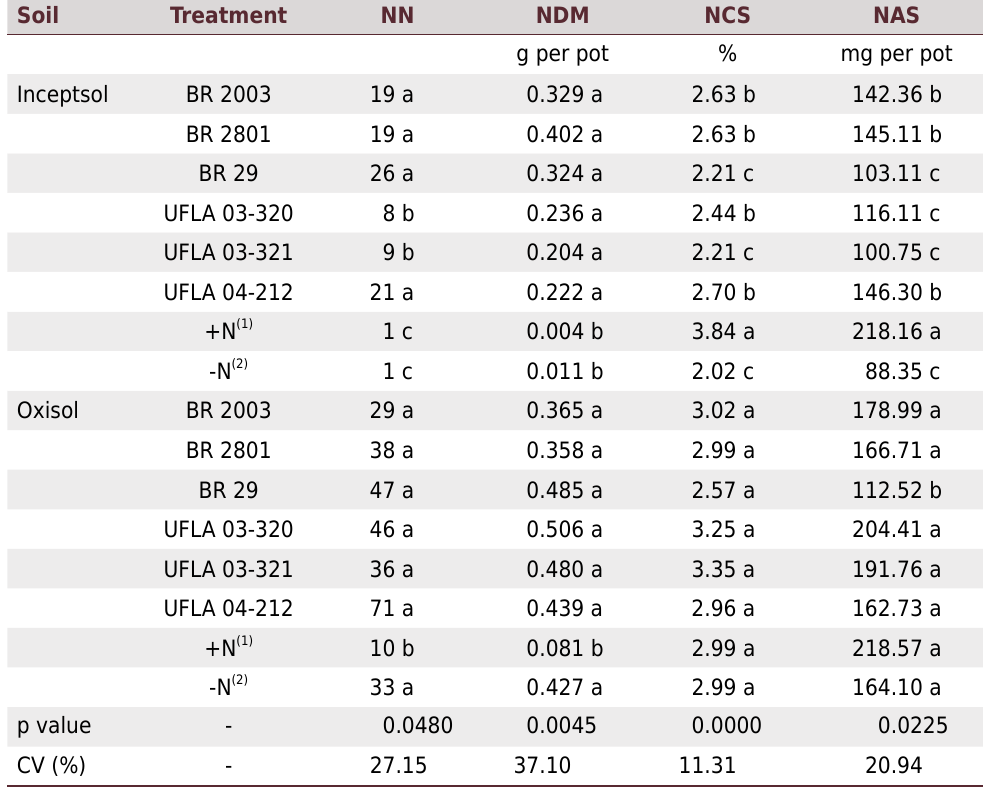
Table 4. Number of nodules (NN), nodule dry matter (NDM), nitrogen content in the shoot (NCS), and nitrogen accumulation in the shoot (NAS) of pigeon pea cv. IAC Fava-Larga cultivated in pots with soil, as a function of treatments and soil Soil Treatment